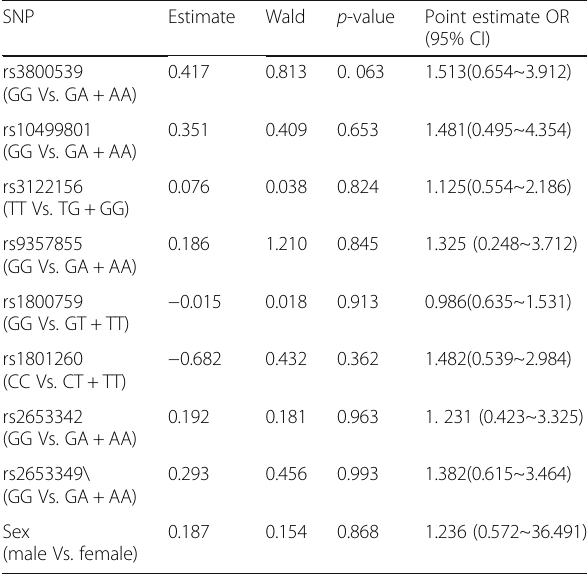
Table 4 Multiple logistic regression of the relation between the 8 polymorphisms and CH SNP Estimate Wald p